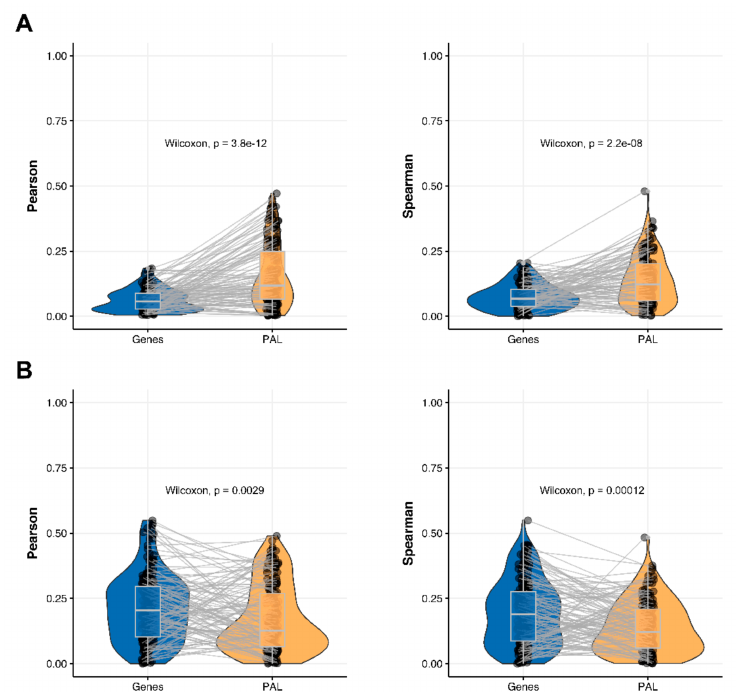
Figure 6. Paired gene-to-gene and PAL-to-PAL correlation between RNA and protein expression lev- els estimated within Hepatocellular Carcinoma biosamples using Pearson ( left ) and Spearman ( right ) correlation coefficients for ( A ) the total set of genes and molecular pathways; ( B ) the set of drug target genes and molecular pathways